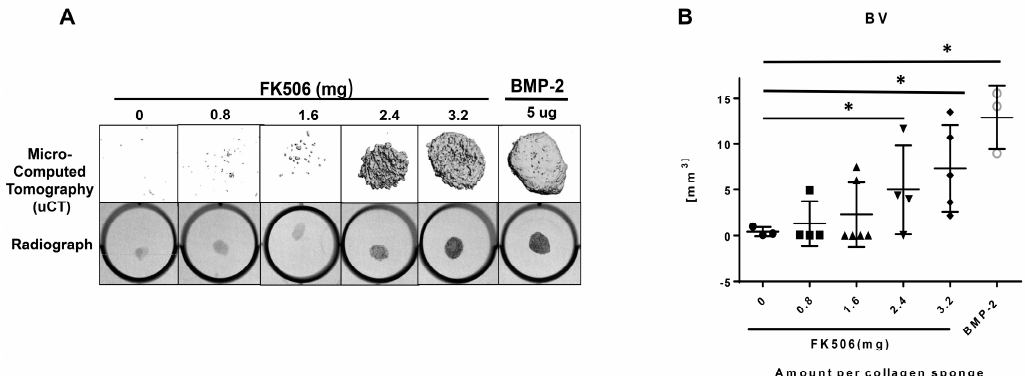
Figure 7. Ectopic bone induction at four weeks by FK506. There was a dose-dependent increase in bone formation. Significant di ff erences compared with implants treated with the vehicle (DMSO)—i.e., the control group—were found at the 2.4 and 3.2 mg doses of FK506. Typical radiographs of the ectopic ossicles in the various treatment groups are also shown. The radiopaque areas of the FK506-treated groups (0.0, 0.8, 1.6, 2.4, and 3.2 mg / 100 µ L / disc, n = 3–6) were larger and more dense than those in the control group. ( A ) A digital radiographic evaluation of the collagen disc implants with varying amounts of FK506. This demonstrates the ability of FK506 to create bone with no exogenous BMP-2. ( B ) Quantitative micro-computed tomography (microCT) measurements of Bone Volume (BV) (mm 3 ) that correlate with the dose of FK506 implanted ( p < 0.05). There is a significant di ff erence in bone volume when comparing 2.4 and 3.2 mg of FK506 as a stand-alone agent and BMP-2 to the implants treated with the vehicle (statistical significance indicated by asterisks). However, there is no significant di ff erence between those two doses of FK506 and implants treated with BMP-2, indicating comparable bone osteoinductive capabilities.